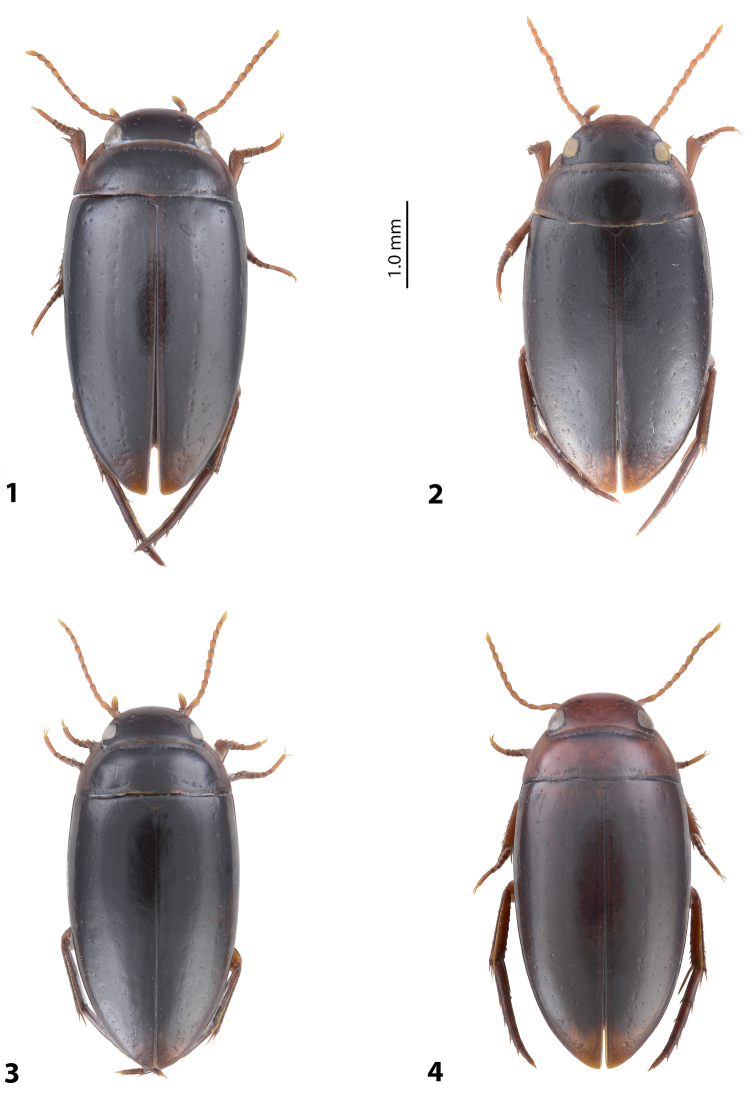
Habitus and colouration 1Exocelina
aipomek (Balke, 1998) 2E.
mekilensis sp. nov. 3E.
koroba sp. nov. 4E.
morobensis sp. nov.